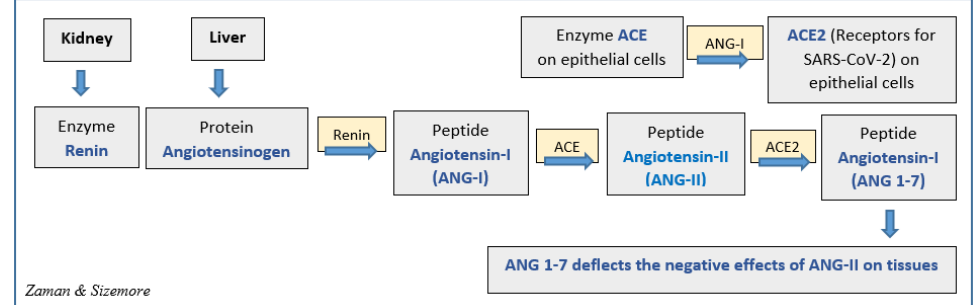
Figure 2. Possible role of ACE2 receptors and angiotensin peptide hormones in SARS-CoV-2 infection.